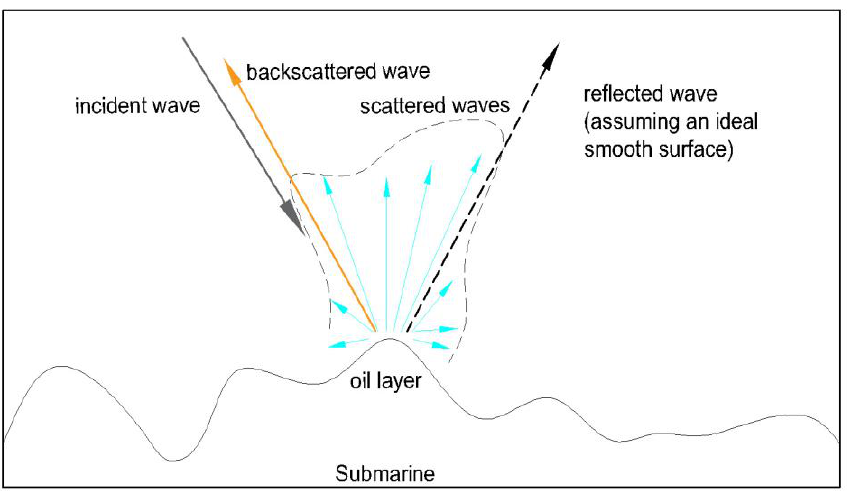
Figure 3. The principle of the acoustic wave (back) scattering phenomenon. (The black solid line represents the incident wave. the yellow solid line represents the backscattered wave. The black dashed line represents the reflected wave. The blue line in the dashed box represents the scattered wave. The blank part represents the seawater medium, and the black curve below represents the oil layer medium.)